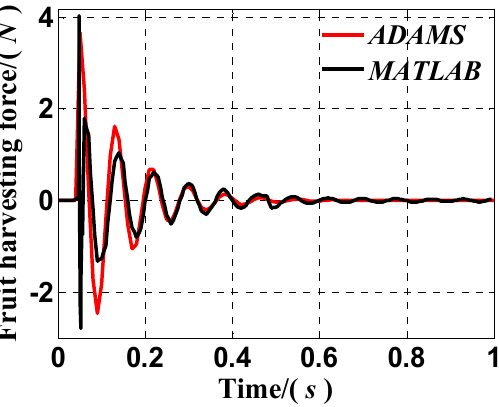
Figure 13. Fruit harvesting force curves of the blueberry branch.